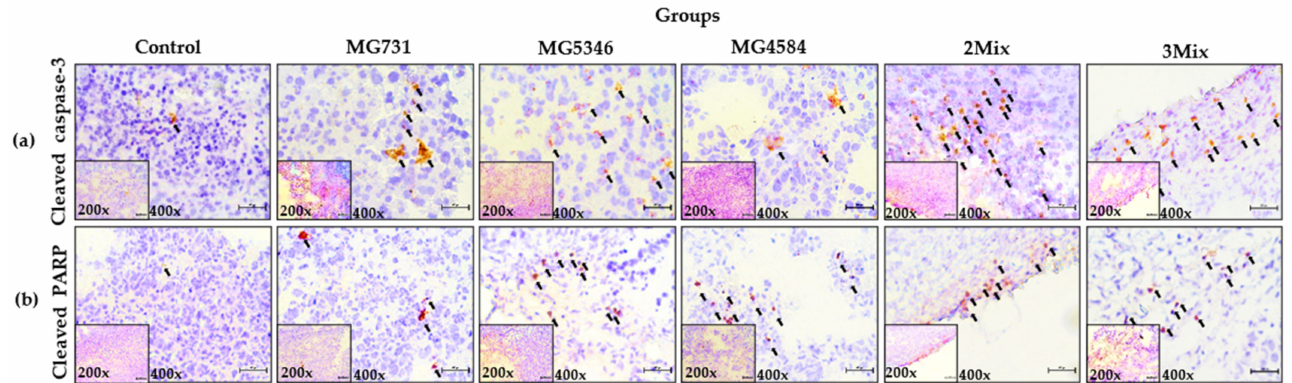
Figure 5. Cleaved caspase-3 and PARP in tumor tissues analyzed by immunohistochemistry (IHC). After 19 days of treatment with heat-killed single strains or their mixtures, tumor tissues were harvested and stained by IHC. ( a ) Cleaved caspase-3, ( b ) cleaved PARP. Black arrows indicate the dots of cleaved caspase-3 and cleaved PARP (magnification 20 × or 40 × as indicated). The scale bar represents 200 px. Control, drinking water; MG731, B. bifidum MG731 (1 × 10 9 cells/mouse); MG5346, L. reuteri MG5346 (1 × 10 9 cells/mouse); MG4584, L. casei MG4584 (1 × 10 9 cells/mouse);